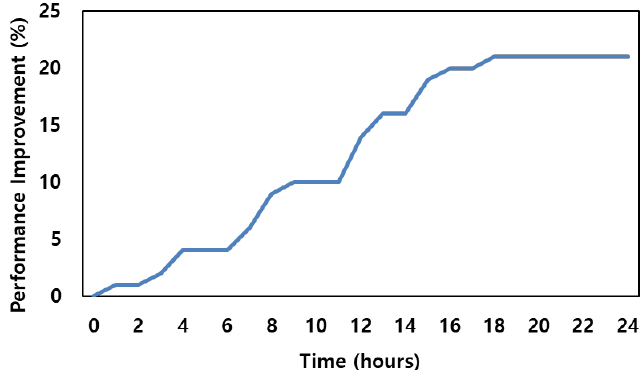
Figure 6. The degree of performance improvement over time in online learning.